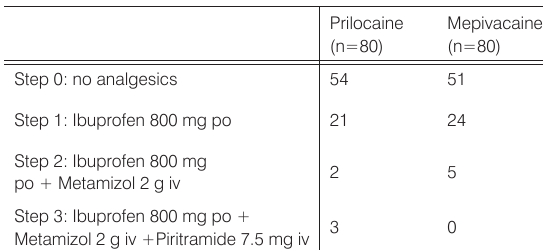
Table 4. Analgesic consumption in the PACU. Analgesics were ap - plied according to the step diagram for the administration of analgesics (Figure 1), po = per os, iv = intravenously, p = 1.0 (Cochran-Armitage trend